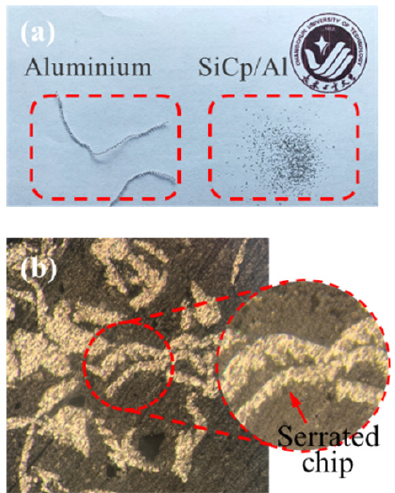
Figure 13. Microstructure of chips under a cutting speed of 250 mm/s and a cutting depth of 25 µ m ( a ) aluminum alloy; ( b ) SiC p/Al composites.